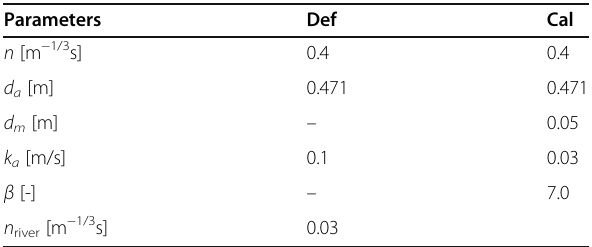
ones (Cal). The default model parameters represent only saturated subsurface and surface runoff, while the calibrated ones used only in the Kanto Region for T19 represent also the effect of unsaturated subsurface